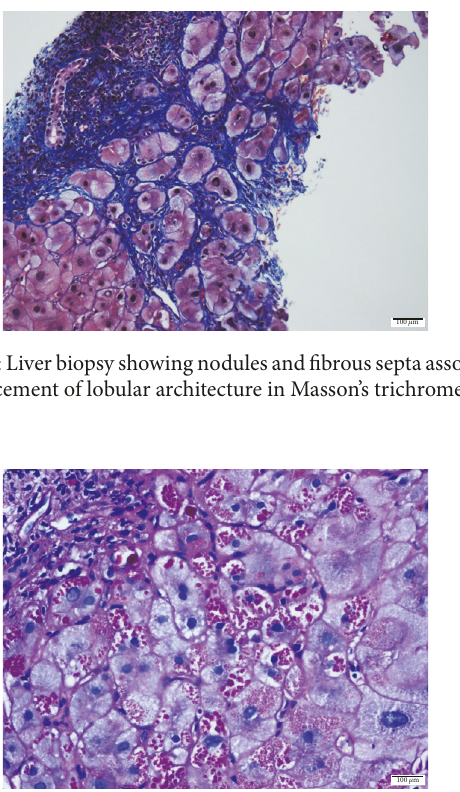
Figure 4: Liver biopsy showing the periportal localization of peri- odic acid-Schiff positive inclusion bodies, confirming the diagnosis of alpha 1 antitrypsin